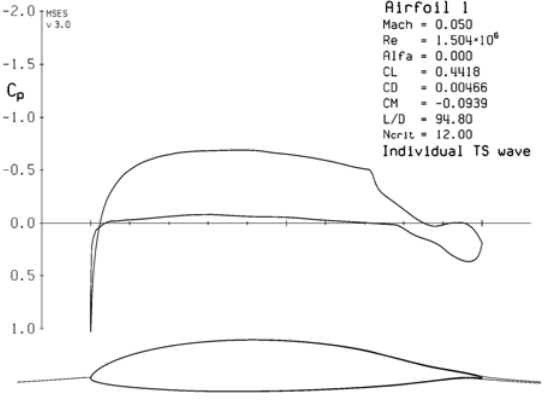
Fig 3. Pressure distribution on a typical section of sailplane